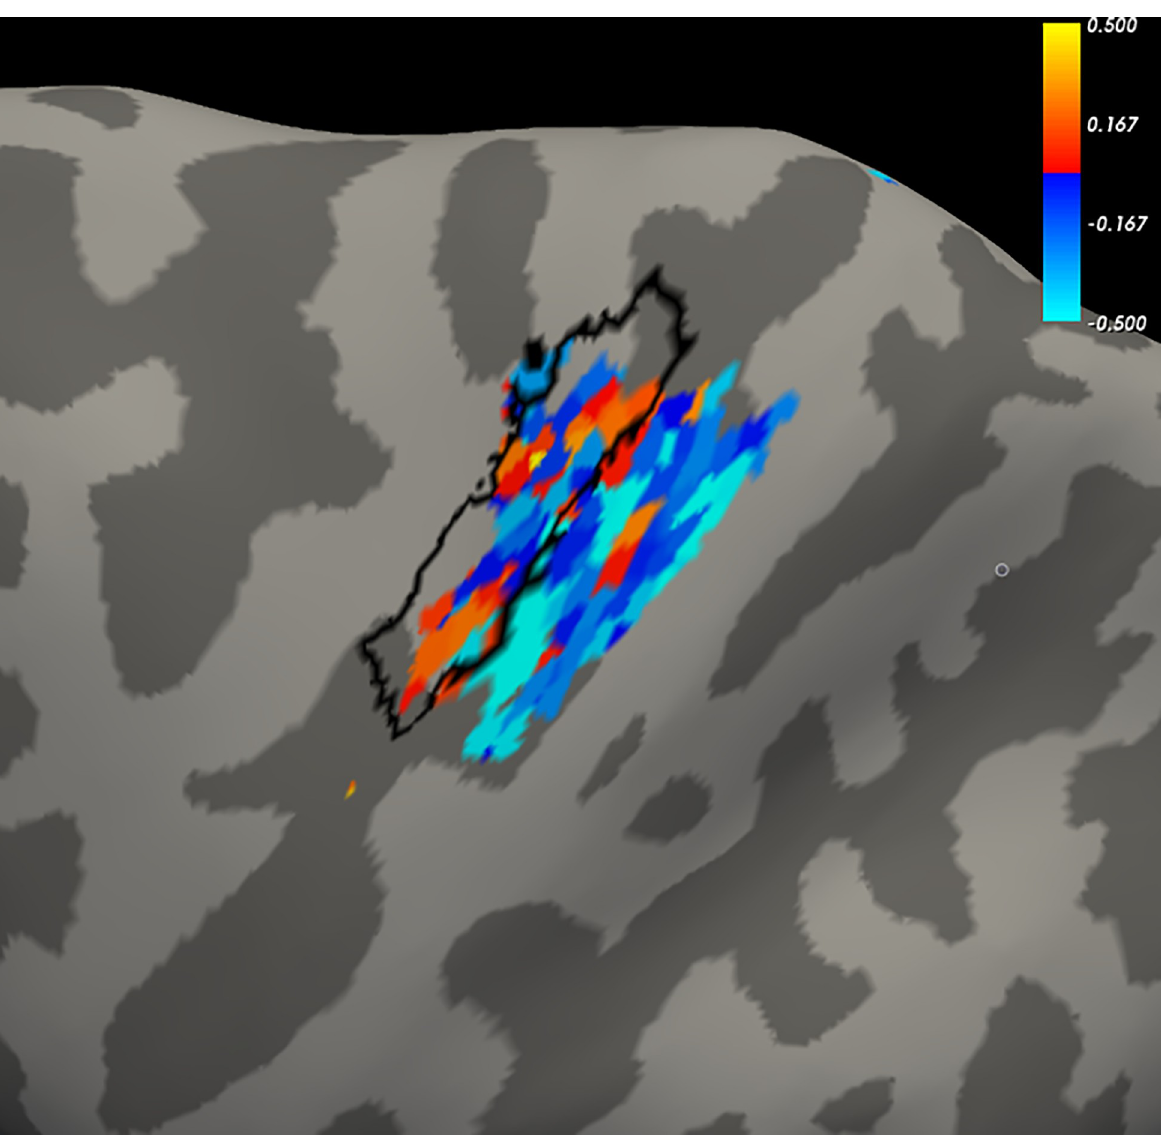
Fig 8. Subject 1 example heat map of wrist action preference (remaining individual subject data are located in the S1 File). Surface projections of native acquisition images show left primary motor (L BA4ap) and left primary somatosensory (L BA3ab) to illustrate co-localization of voxel preferences for extension (yellow/red) and flexion (blue/aqua), as determined by the difference in percent signal change from rest. The cortical surface of the hand knob is outlined in black. Functional percent signal change was calculated for all voxel time courses. The wrist extension reference was calculated as 100 X (extension signal—baseline)/baseline; and the flexion reference was 100 X (flexion signal—baseline)/baseline. The extension and flexion signals were calculated as the mean voxel time course over the movement condition (averaged across all trials). The baseline values were calculated using the median value of the preceding and the subsequent rest periods, which were then averaged, to minimize effects of residual drift. Difference between extension and flexion was calculated for each run. Voxels were filtered using a union of t-maps for ’wrist extension versus rest’ and ’wrist flexion versus rest’ (i.e., active voxels for wrist extension, wrist flexion, or both; t threshold, p < 0.001 uncorrected, such that only suprathreshold activated voxels were considered for further analysis. Session average was the mean of the derived extension-flexion percent signal change across runs within the